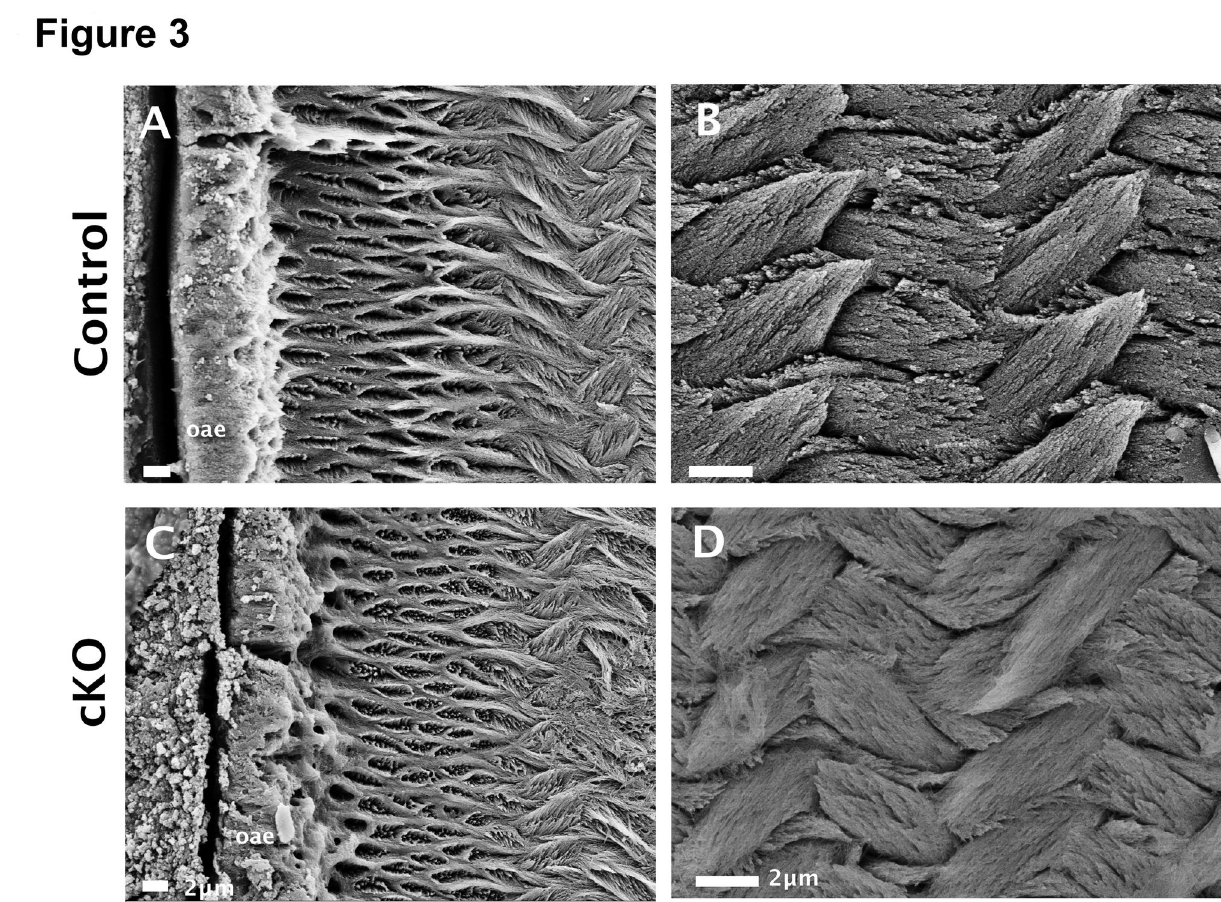
Figure 3. Aprismatic enamel and thinner crystals in cKO mouse enamel. SEM analysis showing irregular and porous outer aprismatic enamel (oae) (panel C, bar = 2 µm) and thinner crystallites in the subjacent prismatic enamel (panel D, bar = 2 µm) as compared to the controls enamel (panels A and